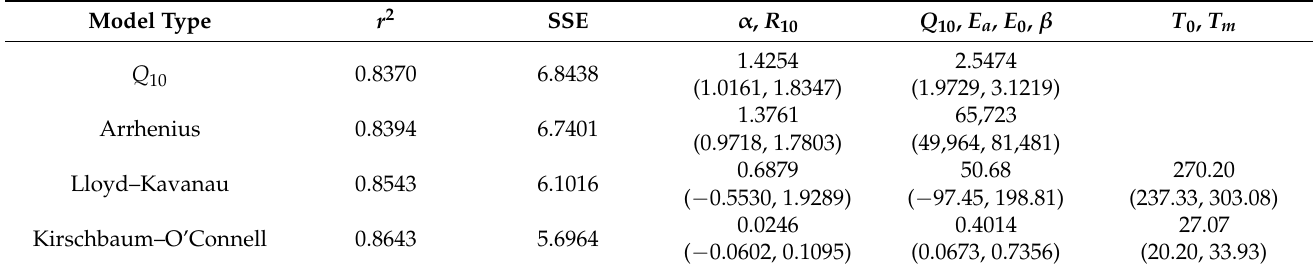
Figure 6. Temperature response of soil respiration rate for the paired plots in different treatments. Plots #1–3 are control treatments; Plots #1 (cid:48) –3 (cid:48) are trench treatments. Plots #1–3 are paired to Plots #1 (cid:48) –3 (cid:48) from the forest gap, upper slope, and lower slope valley, respectively. The regression line was fitted using a two-parameter exponential growth equation. Table 1. Summary table for comparison of the fitting of four models for soil heterotrophic respiration. Values in parentheses are 95% confidential intervals of each estimated parameter; r 2 represents the determinant coefficient; SSE is the sum of squared